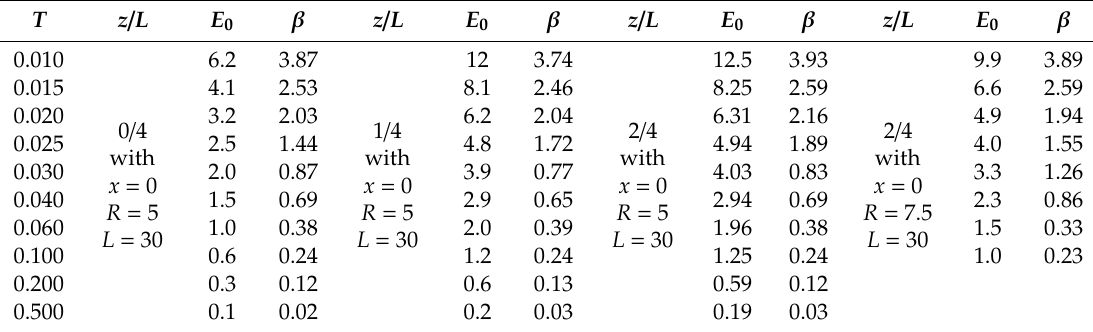
Table 2. The initial total energy ( × 10 4 J) and the ratio β at di ff erent T /